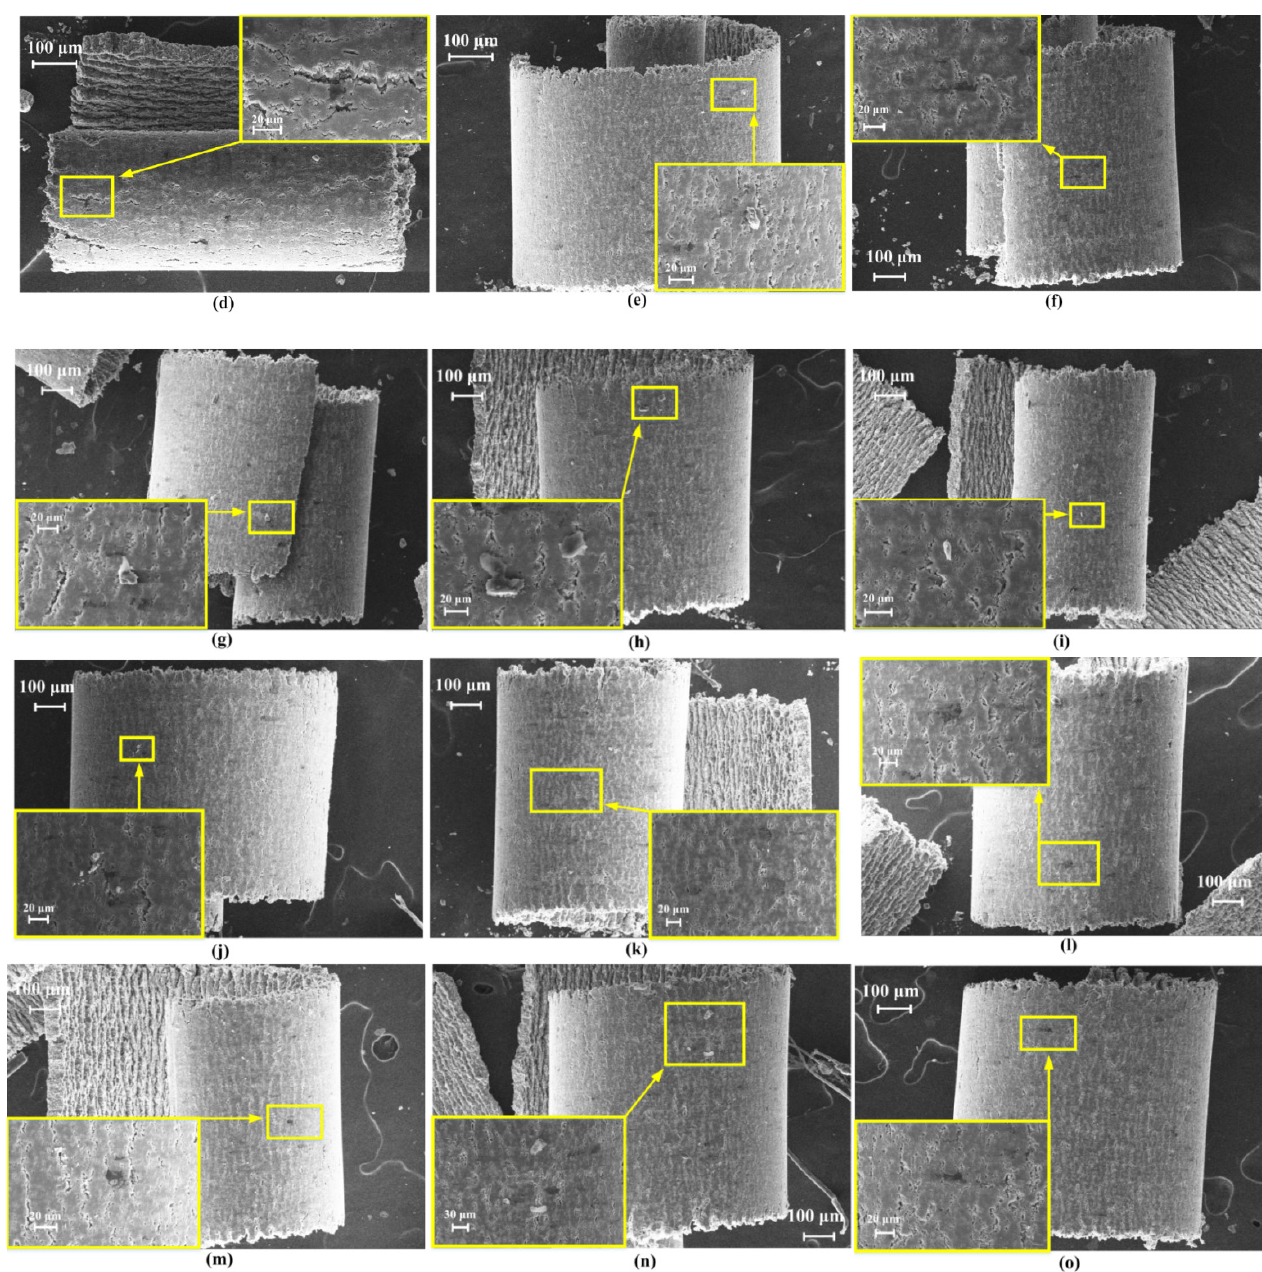
Figure 10. SEM images of chip surfaces machined by micro-pit-textured PCD Tools. ( a – o ) correspond to tools 2 to 16.